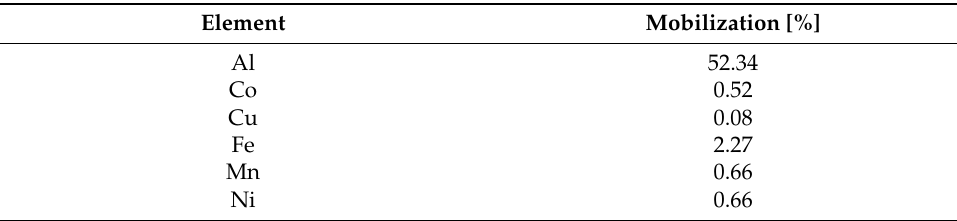
Table 5. Co-mobilization of selected elements at 230 ◦ C, 4 h, and L:S ratio = 90